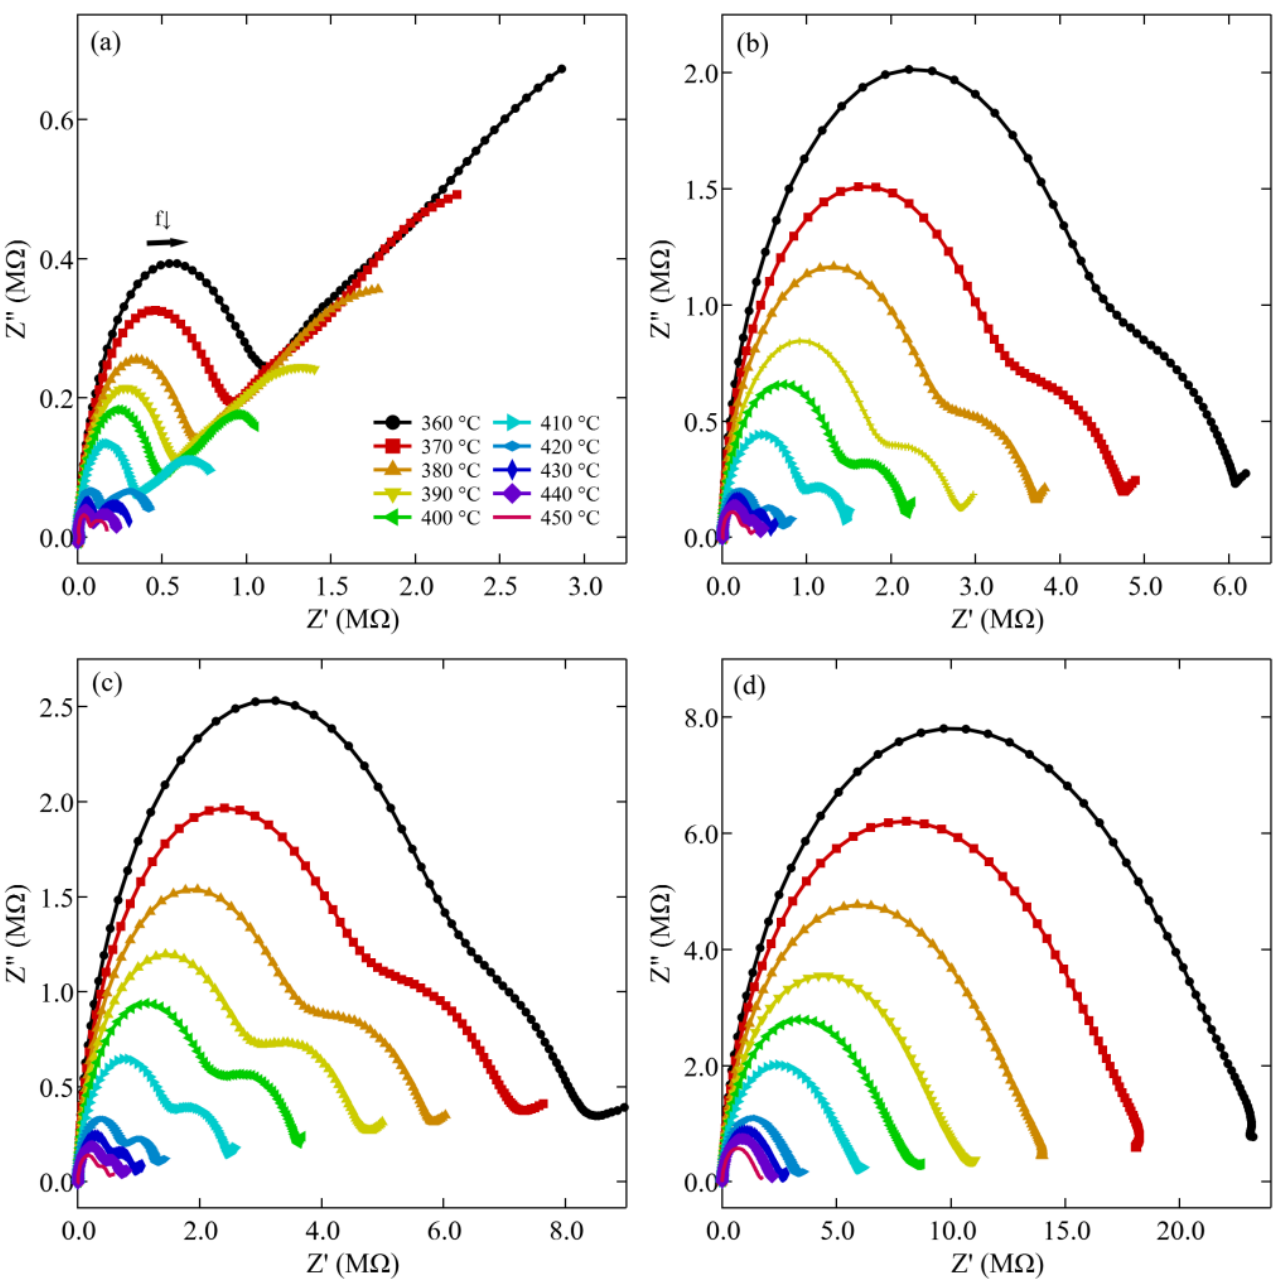
Figure 2. Nyquist plots of NKN with ( a ) 0 vol%, ( b ) 5 vol%, ( c ) 15 vol%, and ( d ) 25 vol% Al 2 O 3 . To gain more insight, the imaginary part of the impedance (Bode plot), as well as the electrical modulus, is shown as a function of frequency (Figure 3). Similar to the Nyquist plots discussed earlier, two relaxation processes can be observed for all composites for the Bode plots. At 360 ◦ C, the relaxation frequency for the bulk material is in the range of 0.1–1 kHz. At lower frequencies, around 10 Hz, the relaxation process for the grain boundary can be observed. In general, the relaxation frequencies of a material depend on the conductivity σ , as well as on the relative permittivity ε r